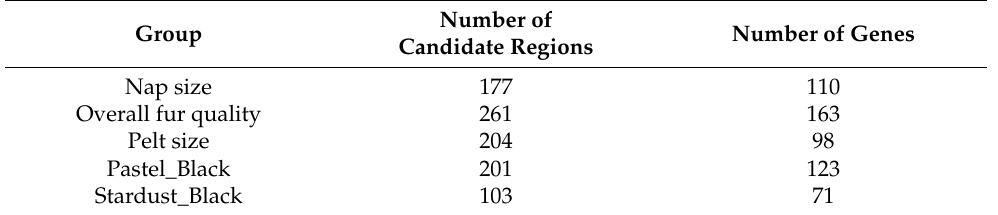
Figure 2. Genome-wide distribution of XP-EHH across chromosome regions in different groups of fur quality and coat color in American mink. The horizontal lines indicate the top 1% of values for each test across the entire genome. High positive values indicate the selection in short nap size ( a ), high overall fur quality ( b ), large skin size ( c ), pastel coat color ( d ), and stardust coat color ( e ). Table 1. Number of candidate regions and genes detected by overlapping Fst and XP-EHH in differential phenotypic groups of fur quality and coat color in American